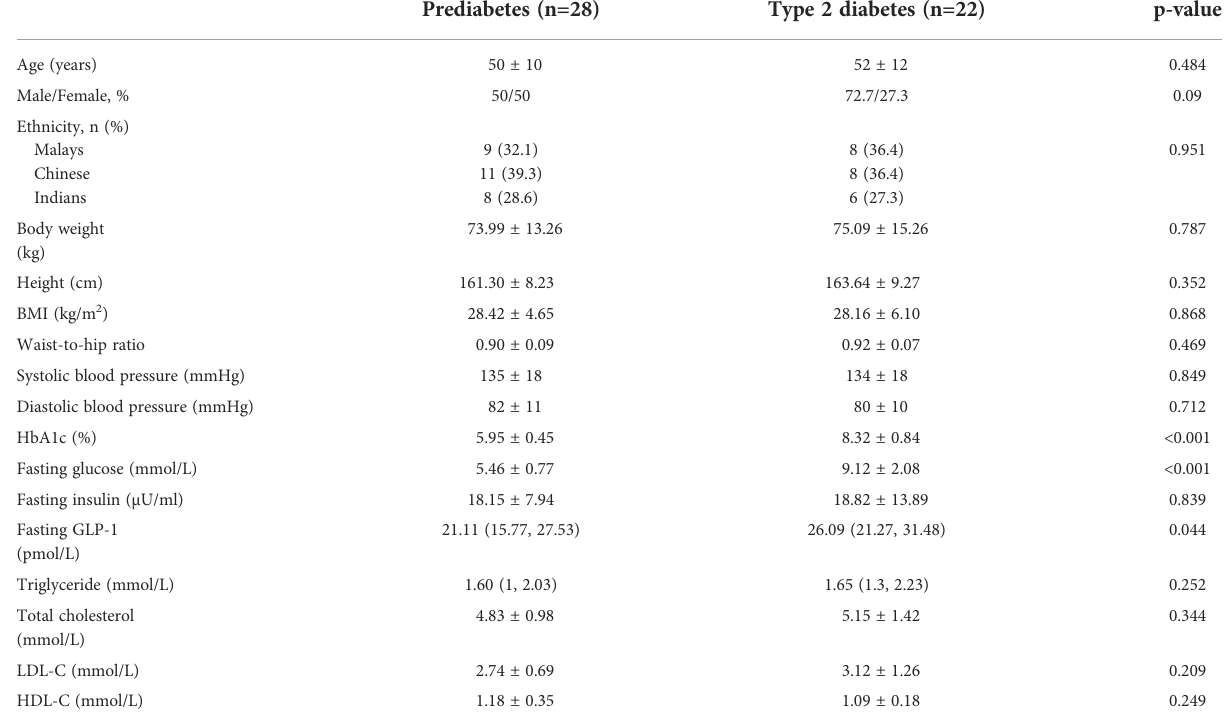
TABLE 1 Baseline demography and clinical characteristics of prediabetes versus type 2